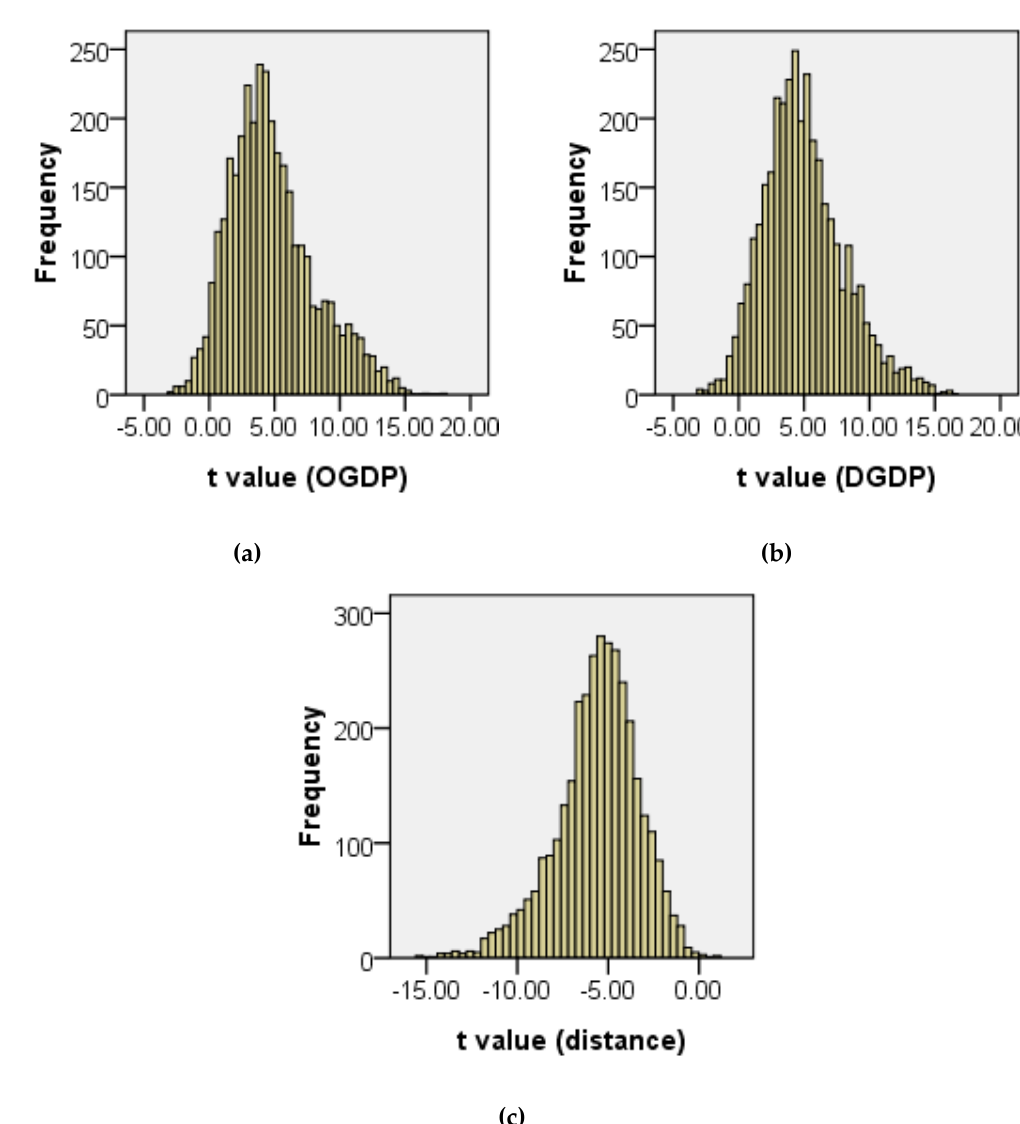
Figure 9. Histograms of t-statistics for three parameter estimations with the geographically weighted negative binomial regression (GWNBR) model. ( a ) OGDP; ( b ) DGDP; ( c ) distance.